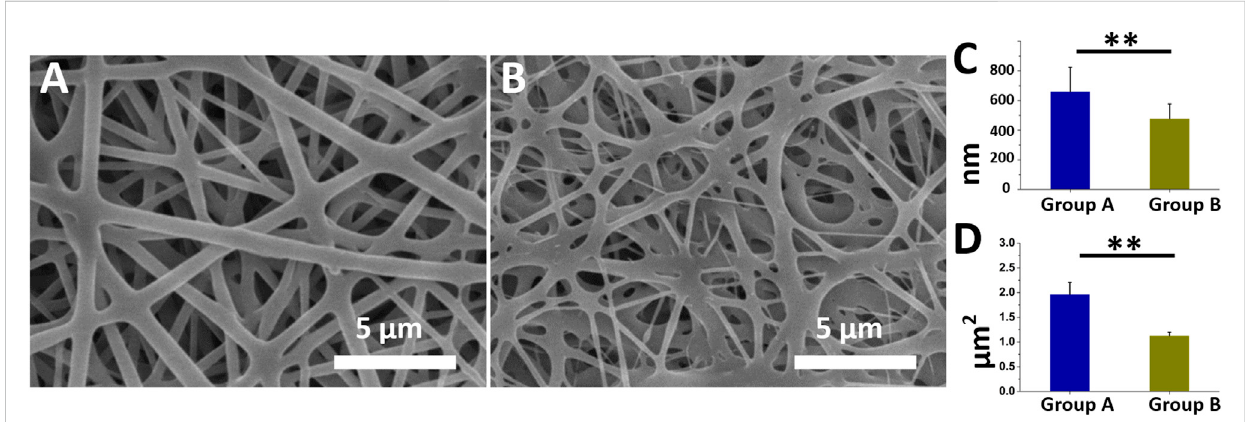
FIGURE 1 Twoelectrospun nano fi berswereexaminedutilizing SEM.Appearanceofinsulin/vildagliptin-eluting (A) ,and insulin/PLGA nano fi bers (B) .Diameters (C, D) , and E and pore areas (F, G, and H) in two groups were determined using ImageJ (Scale bar: 5 μ m). ** p < 0.01.